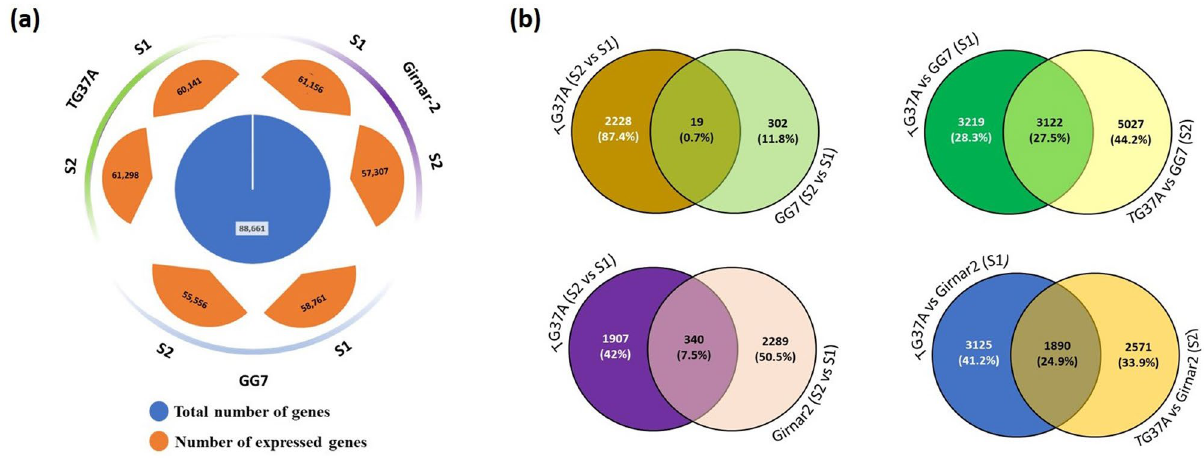
Figure 2. Diagrammatic representation of the number of Differentially Expressed Genes (DEGs) in different combinations of peanut seed sample. (a) Genes with at least one mapped read have been considered. The total number of genes has been represented in a blue circle while the number of expressed genes (orange) in TG37A (green), Girnar 2 (purple), and GG7 (light blue) at maturing seed (S1) stage and matured seed (S2) stage have been represented using different colors. (b) The figure has been partially designed using venny 2.1 webtool (https:// bioin fogp. cnb. csic. es/ tools/ venny/ index. html). Seed maturity stages has been denoted by S1 (maturing seed stage) and S2 (matured seed stage). Combinations of two samples have been represented with versus of genes showed significant expression and of 2247 DEGs, 13.4% were upregulated and rest were downregulated. In Girnar 2, 4.2% of the genes showed upregulation (of 15.8% of expressed genes), while 84.2% showed down- regulation. When contrasting varieties (TG37A and GG7) were analyzed at S1, 10% genes showed significant expression and of these, 42.4% were upregulated, while 57.6% were downregulated. When analyzed at S2, 13% of the genes were significantly expressed and of these, 63.8% were downregulated, while rest showed upregulation. On comparing TG37A and Girnar 2, 7% and 8% of tested genes (62,987) showed significant expression at S1 and